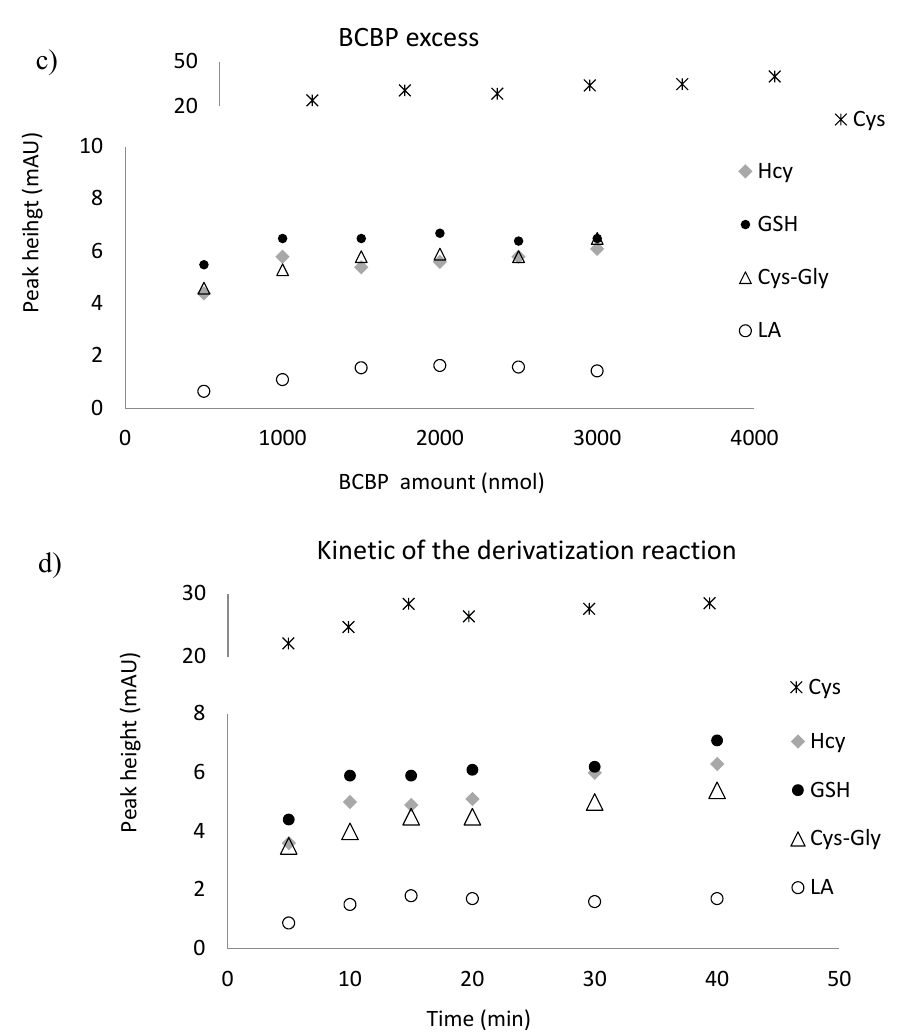
Figure 4. The influence of 1-benzyl-2-chloropyridinium bromide quantity, pH of the reaction mixture, and time on derivatization reaction yield of dihydrolipoic acid, reduced glutathione, cysteine, cysteinylglycine, and homocysteine. ( a ) Reaction of 1-benzyl-2-chloropyridinium bromide with dihydrolipoic acid carried out in 0.2 mol L − 1 , phosphate buffer, pH = 9.0; ( b ) reaction of 1-benzyl-2-chloropyridinium bromide with dihydrolipoic acid carried out in triple excess of the derivatizing reagent; ( c ) derivatization reaction carried out in 0.2 mol L − 1 , phosphate buffer, pH = 7.8; ( d ) derivatization reaction carried out in 0.2 mol L − 1 , phosphate buffer, pH = 7.8 in 2000-fold excess of the derivatizing reagent.